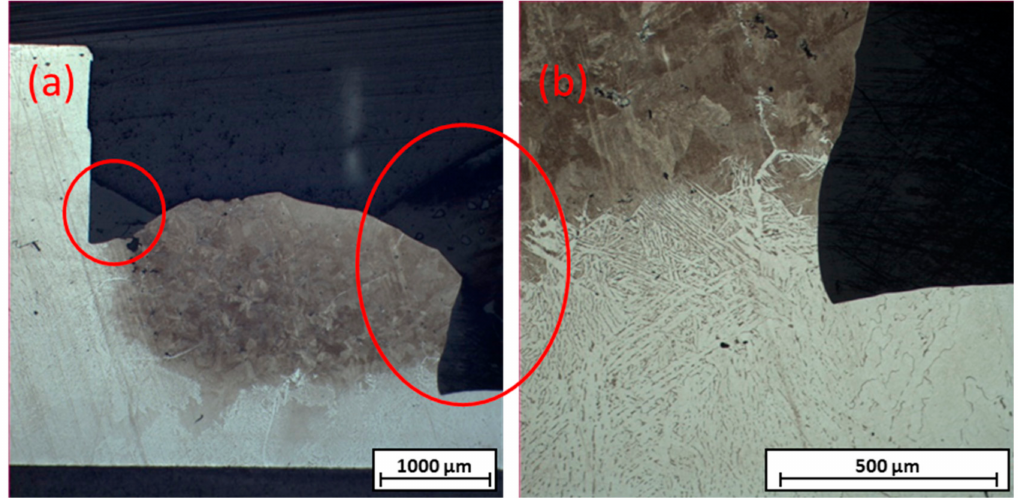
Figure 9. ( a ) Nital etching of crosscut of crucible after experiment with marked slag; ( b ) Magnification of the mixed